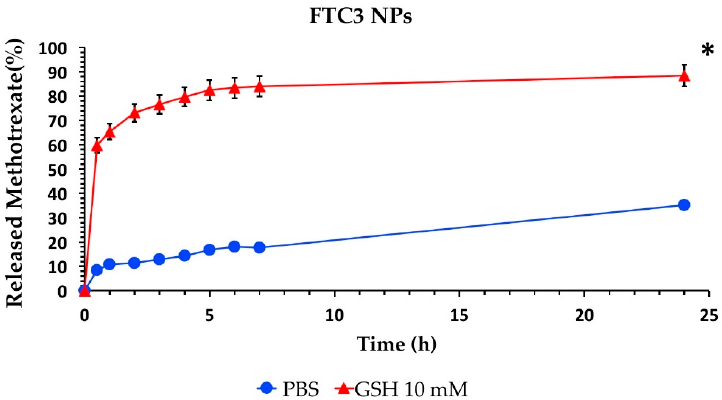
Figure 3. In vitro drug release profiles from methotrexate (MTX)-FTC3 NPs in phosphate buffer in the presence ( ▲ ) and absence ( ● ) of glutathione (GSH) 10 mM at 25 °C (mean ± standard deviation, n = 3). The amount of MTX release in phosphate buffer in the presence of GSH 10 mM at every time point was statistically different (* p < 0.05) from that recorded in the absence of GSH.